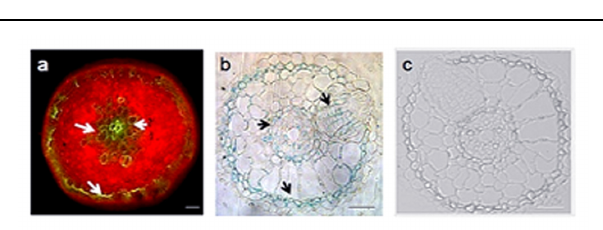
FIGURE 5 | Advanced colonization stages of Arabidopsis root by U. virens expressing GFP and GUS histochemical staining. (a) cortical cells are colonized by GFP-tagged hyphae ( arrow ) after 21 dpi; (b) semi-thin sectioning of Arabidopsis root showing a heavy colonization of epidermis, cortex and the endodermis after 21 dpi by the GUS labeled hyphae; (c) Semi-thin sectioning of an uninfected 21-day-old Arabidopsis root under bright field microscopy (Control). Bars = 100 μ m (a) and 20 μ m (b,c) .